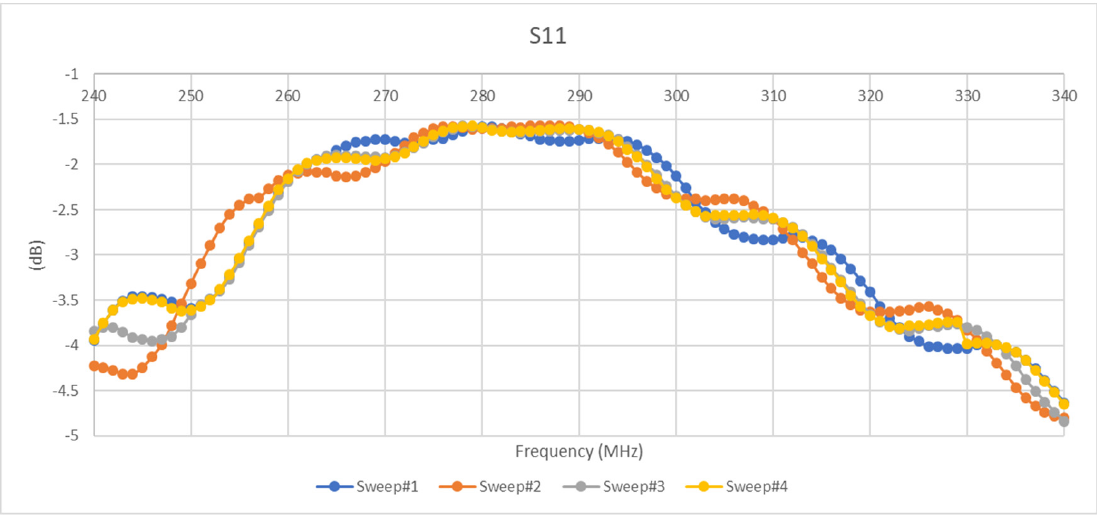
Figure 15. S11 results of sinusoidal excitation.